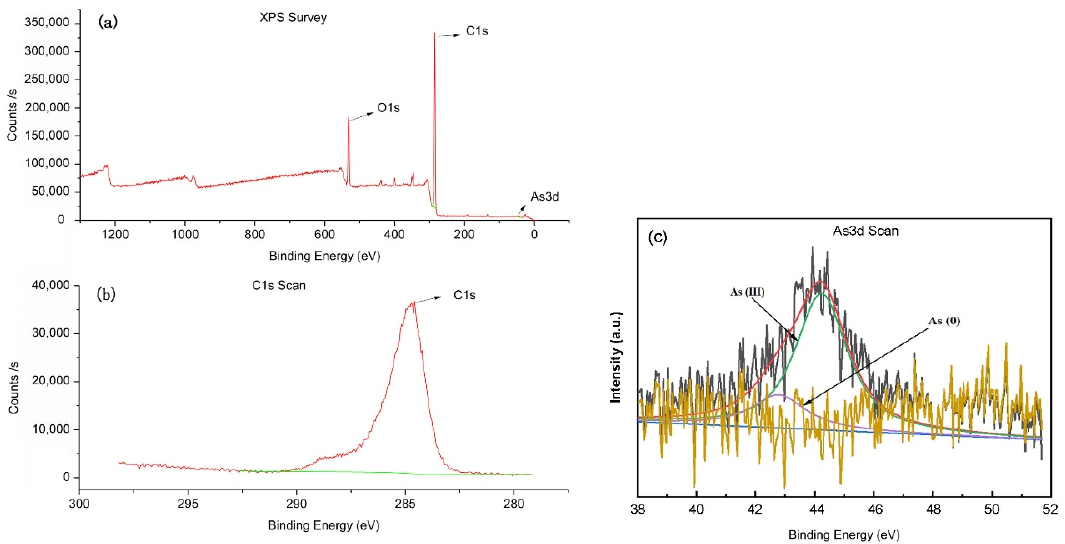
Figure 2. X-ray photoelectron spectroscopy (XPS) of crayfish showed different peak positions ( a ), ( b ) C 1s XPS survey spectrum, and ( c ) As 3d XPS survey spectrum. ( b ) C 1s XPS survey spectrum, and ( c ) As 3d XPS survey